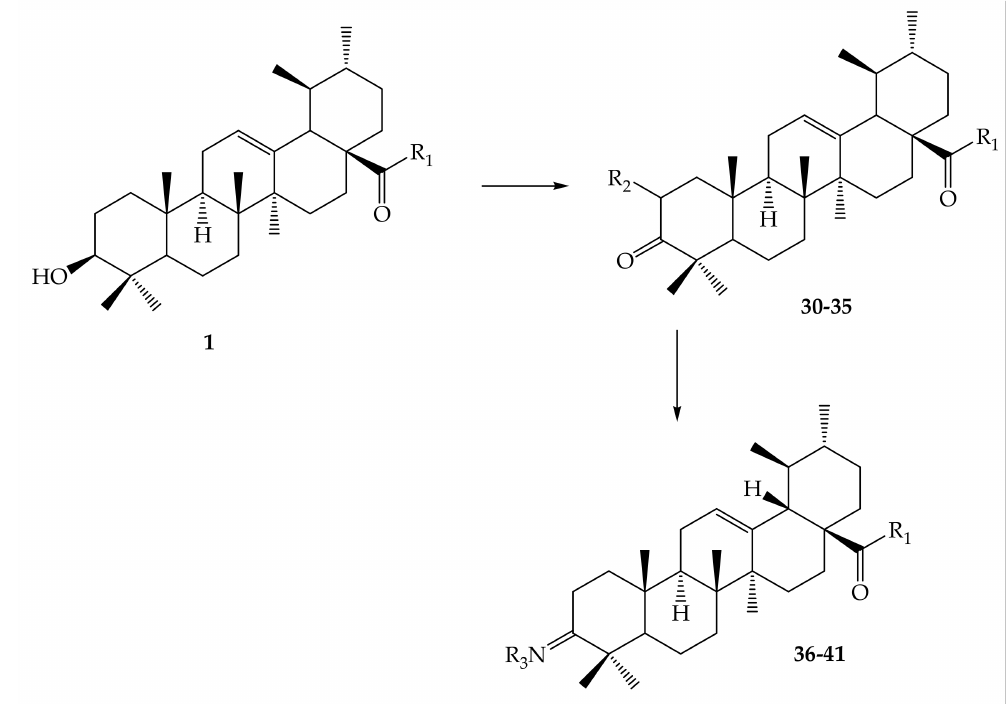
Figure 5. UA analogues. 28–29; 28: R = COH; 29: R = COCH 3 .